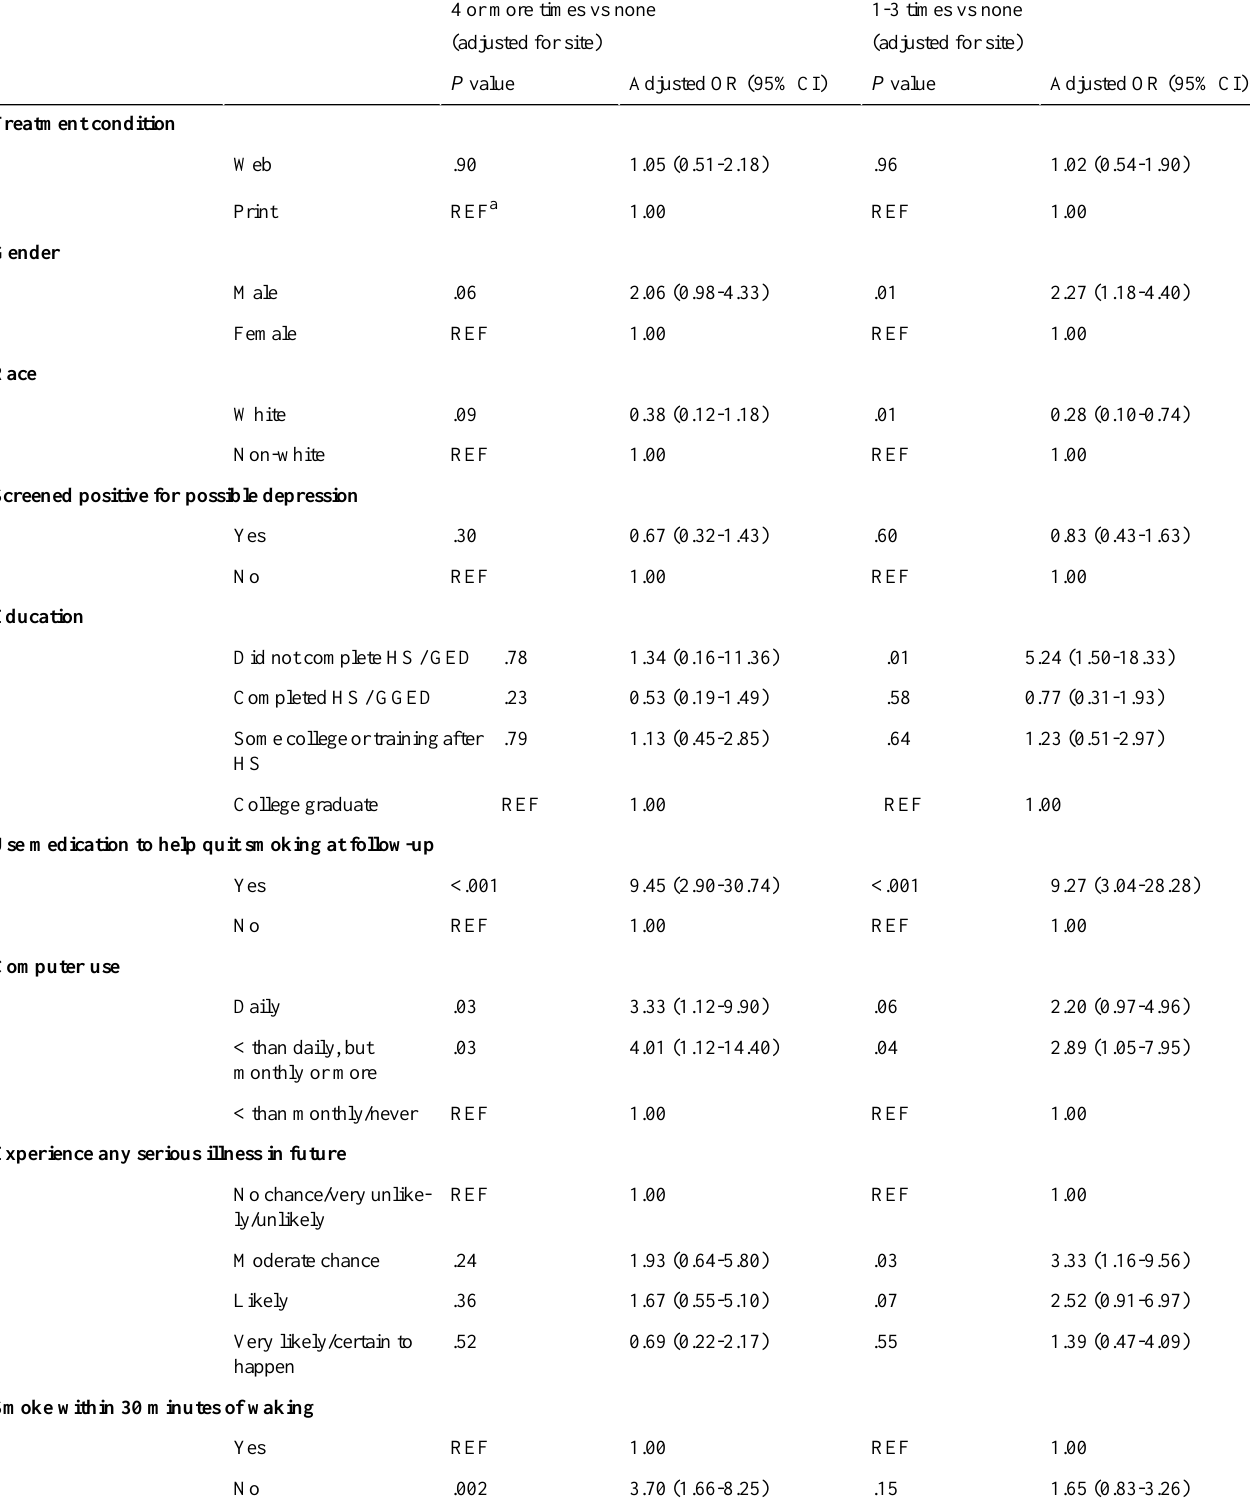
Table 3. Multivariable models predicting quit attempts among smokers at 15-month follow-up